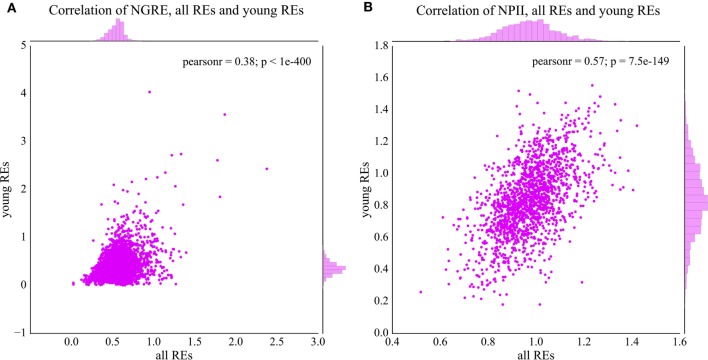
Comparison of normalized transcription factor binding site distributions between the young (0–8% divergence from the respective consensus sequence) and total fractions of REs. (A) Comparison of NGRE scores (gene level of regulation), each dot represents a single gene. (B) Comparison of NPII scores (pathway level of regulation), each dot represents a single molecular pathway. Pearson r—Pearson correlation coefficient; p—Pearson p-value.